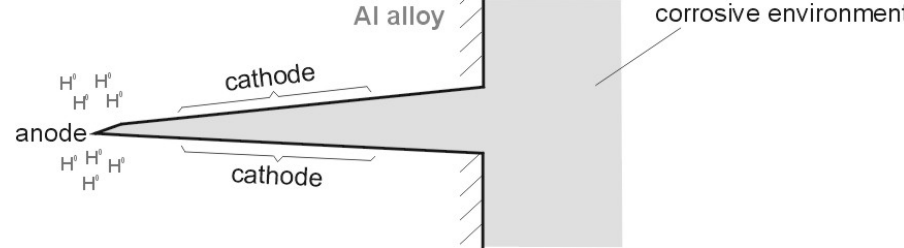
Figure 19. Corrosion cell formed in a crack following hydrogenation of an alloy.